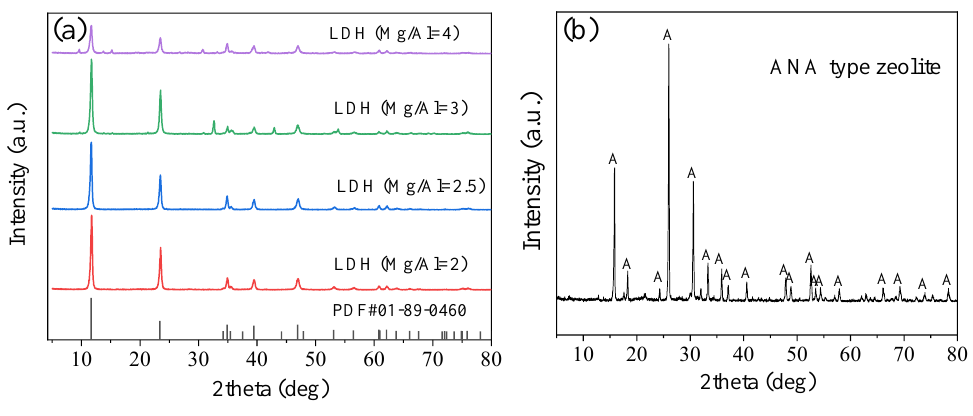
Figure 4. ( a ) XRD patterns of LDHs with different Mg/Al ratio, ( b ) XRD patterns of ANA.